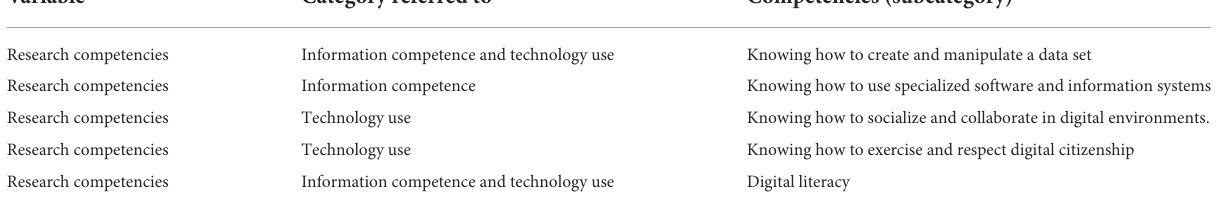
TABLE 1 Variable, category referred to, and competencies (subcategory) in theoretical bases.